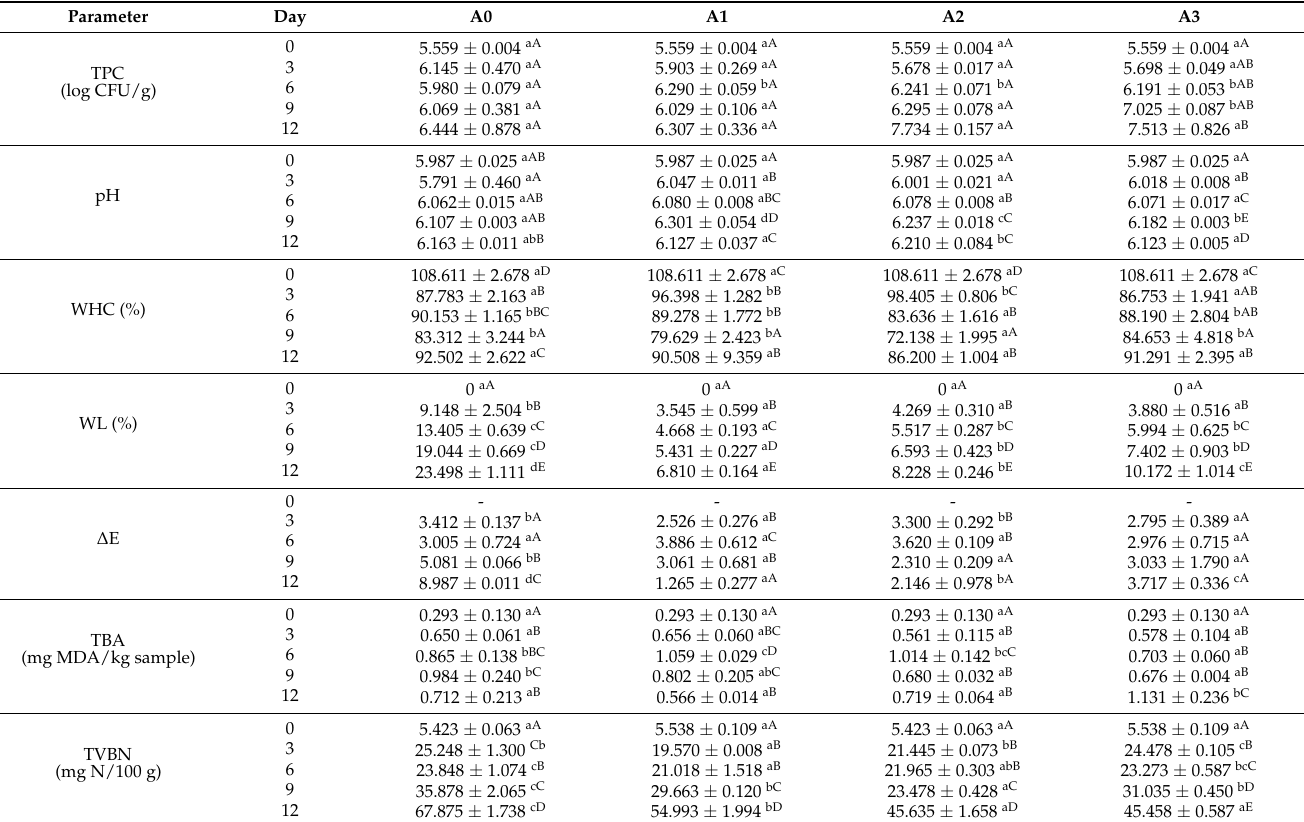
Table 3. Psychochemical and microbiological quality of minced chicken meat packaged with various treatments.